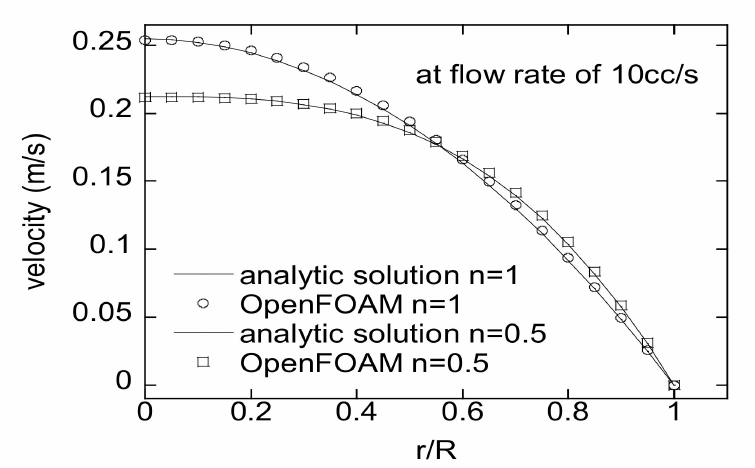
Figure 7. Comparison of an analytic solution and that by OpenFOAM for a Newtonian fluid and a virtual power-law fluid (PLF) of n = 0.5.